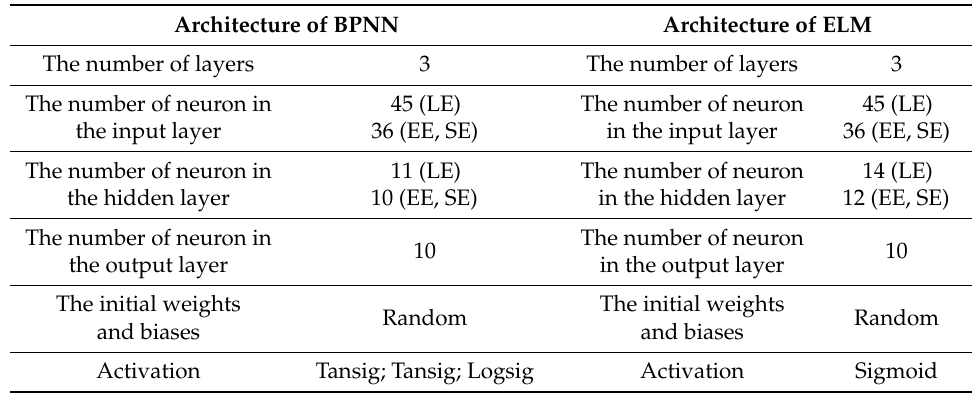
Table 5. The optimal training parameters of BPNN such as learning rate, learning rate reduced factor, learning rate minimum bound, and number of epochs are obtained by five-fold cross-validation [30]. The training parameters of BPNN are as follows: the maximum epoch number is 1000; the learning rule is Levenberg–Marquardt; the moment constant is 0.98; the mean squared error is 1.00 × 10 − 5 [31]. The classification results of different methods are shown in Table 6. Table 5. Structure parameters of ELM and BPNN.